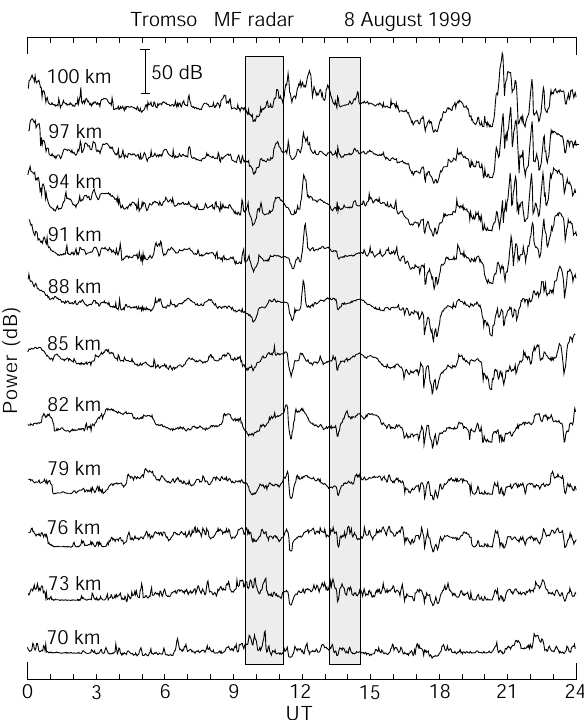
Fig. 3. Time and altitude variations of echo power observed with the Tromsø MF radar. Two PMSE occurrences detected with the Hankasalmi HF radar are lightly shaded.